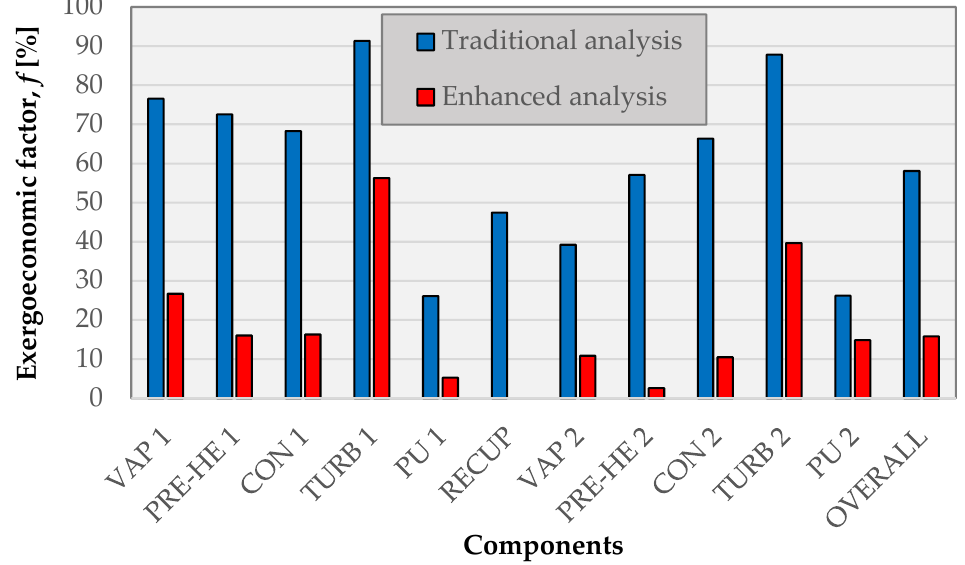
Figure 4. Change in exergoeconomic factor for the components for both analyses.